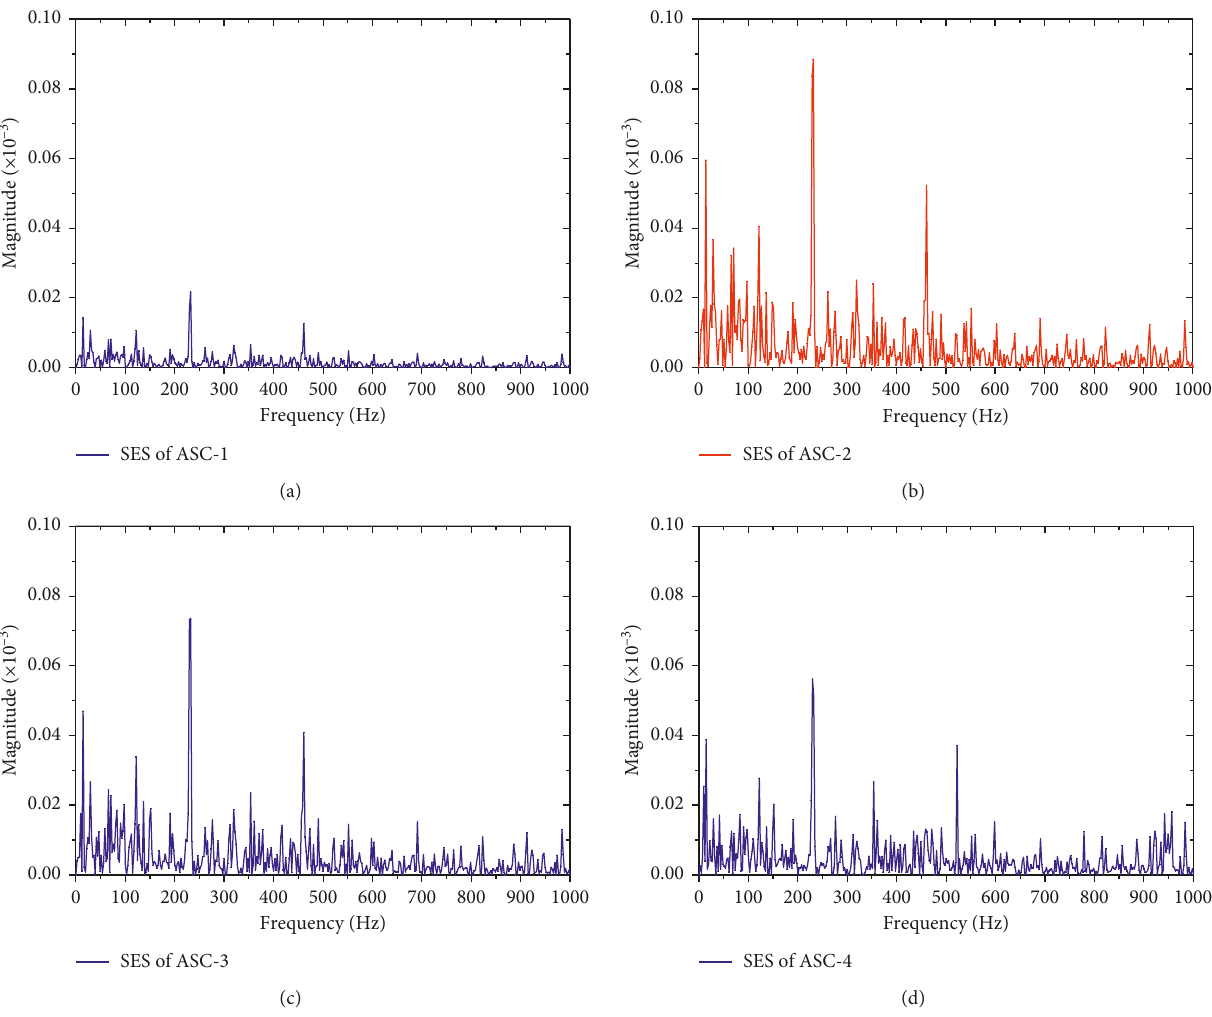
Figure 10: The squared envelope spectrums of first four ASCs: (a) the squared envelope spectrum of 1st ASC; (b) the squared envelope spectrum of 2nd ASC; (c) the squared envelope spectrum of 3rd ASC; (d) the squared envelope spectrum of 4th ASC.